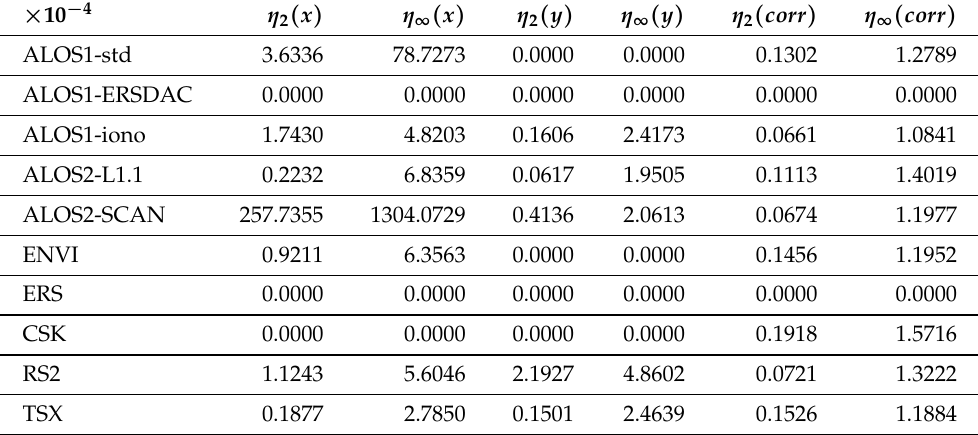
Table 2. Accuracy of xcorr-gpu . Vectorial relative error × 10 − 4 for x and y offsets, and correlation with both two-norm and infinity-norm.